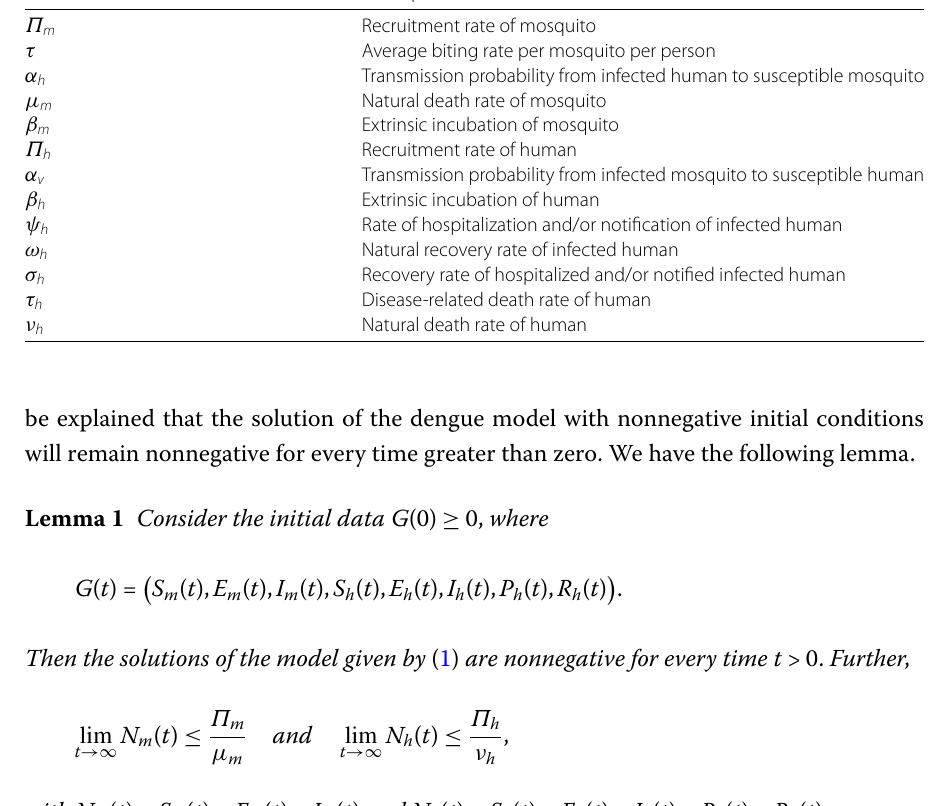
Table 1 Biological meaning of parameters for dengue model (1) Parameter